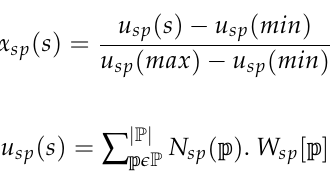
Figure 7. Density of services around stops 𝐀 and 𝐁 .